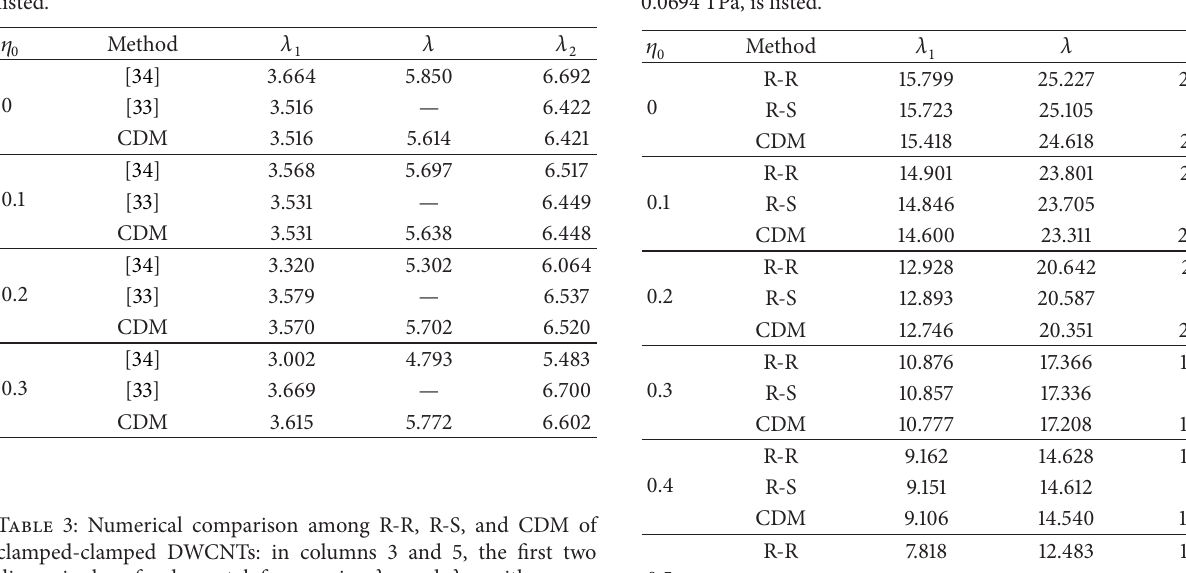
Table 2: Numerical comparison among [33, 34] and CDM of clamped-free DWCNTs: in columns 3 and 5 the first two dimension- less fundamental frequencies 𝜆 1 and 𝜆 2 , with 𝑐 12 = 0 , are reported, while in column 4 the first frequency 𝜆 , with 𝑐 12 = 0.0694 TPa, is listed.